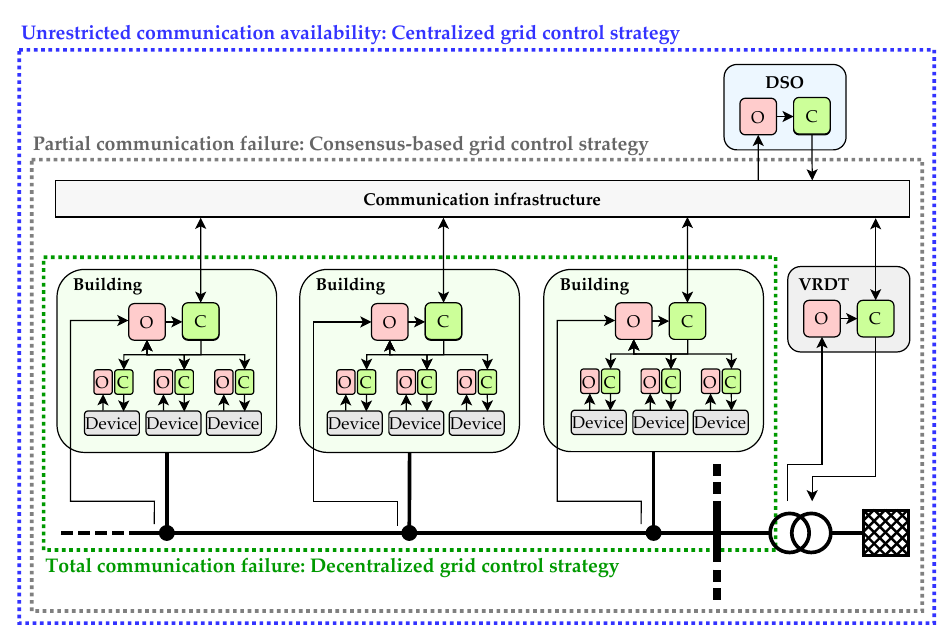
Figure 2. Adaptation of grid control strategies to provide resilience against communication failures. The thick lines indicate electrical connections. The thin arrows indicate communication. O stands for observer and C for controller. Adapted from ref. [21].